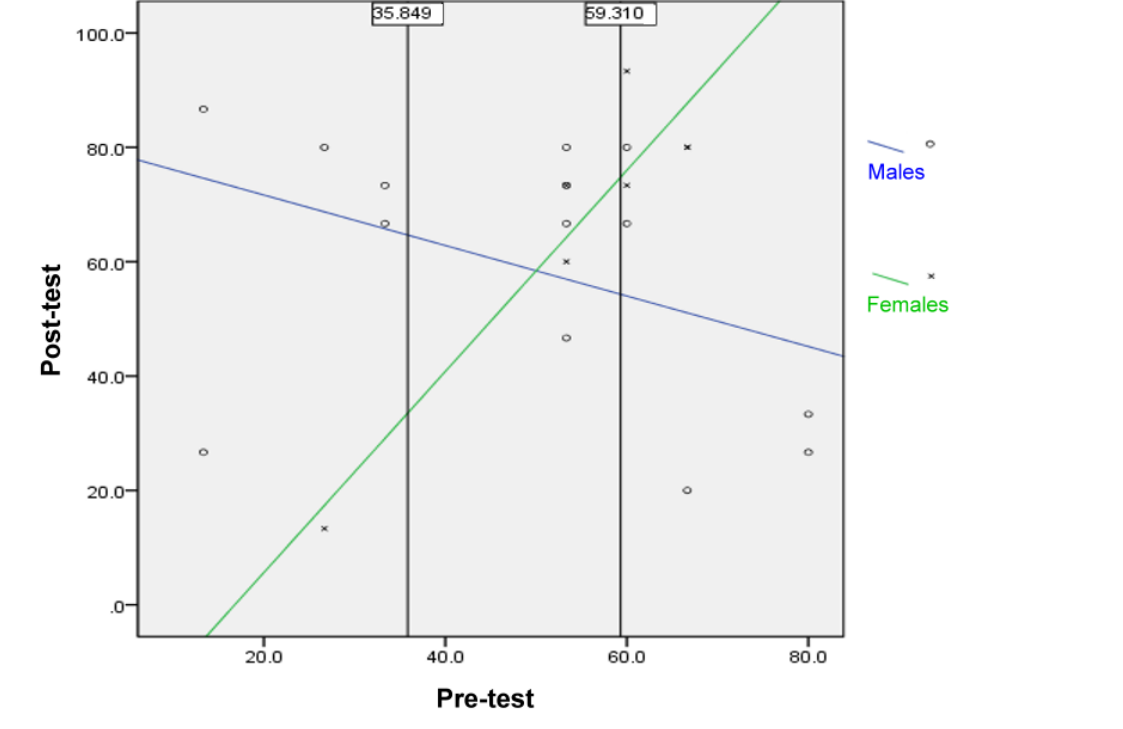
Results of Johnson-Neyman Process for Males and Females Using the Cycle of Doing